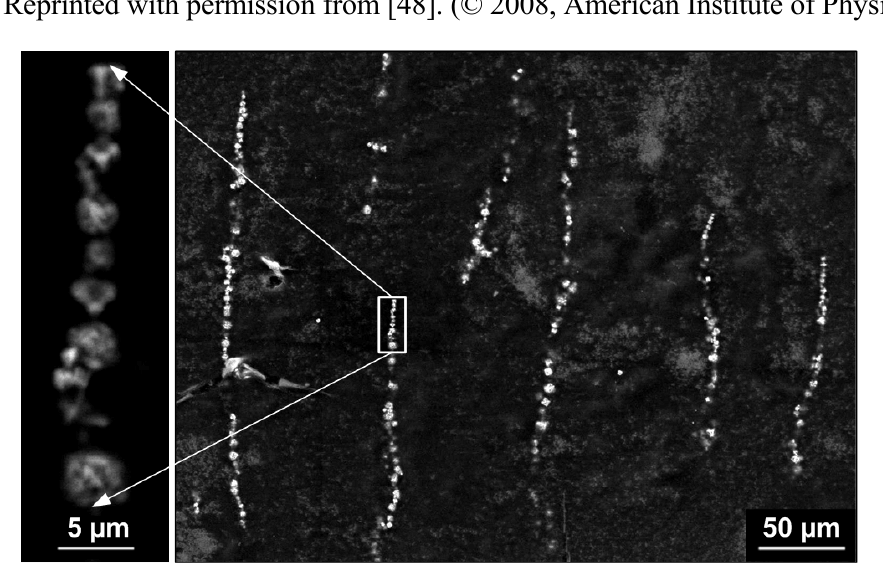
Figure 2. Scanning electron microscopy (SEM) images of conductive SMPU containing 10 vol% of carbon black and 0.5 vol% of chained Ni. Inset: Zoom-in view of one Ni chain. Reprinted with permission from [48]. (© 2008, American Institute of